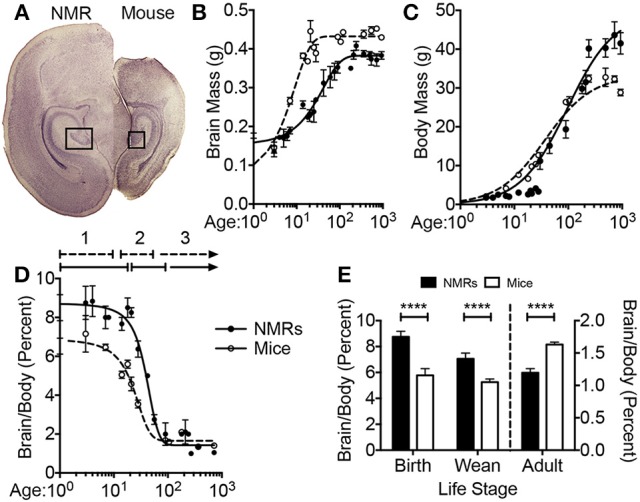
Naked mole-rat brain growth significantly differs from mice. (A) Newborn naked mole-rat (NMR) brains are twice as large as newborn mouse brains; shown are 4x images of 30 μm coronal brain sections stained with hematoxylin. The rectangle outlines the dentate gyrus of the hippocampi from each respective species. (B) Plotting brain mass against age reveals a dramatically different brain growth rate between species. Mouse brains are ~17% of adult mass at birth but by 2 weeks attain 90% of adult brain mass. NMRs brains are ~41% of adult size at birth but do not reach 90% adult mass until 3 months of age. (C) The age of somatic growth surge is similar between species and may reflect the age at which they begins to eat solids (3 weeks in mice vs. 3–6 weeks in NMRs). (D) Plotting the percentage of brain mass to body mass against age illustrates 3 distinct phases of development (1, 2, 3), that differ in length of time between species. The first static phase (1) last twice as long in NMRs as mice (4 and 2 weeks, respectively). The second phase (2) lasts 2 weeks in mice but 9 weeks in NMRs giving rise to the final phase of maintained body and brain mass beginning at 4 weeks in mice and 3 months in NMRs. (E) NMR brains are signifianctly larger than mice, even when normalized to body mass, through the age of weaning. However, adult NMR brains are significantly smaller than mice especially when accounting for body mass. (Student's t-test ****: p < 0.0001).